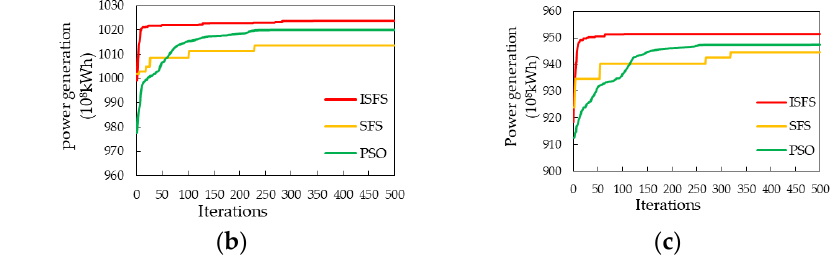
Figure 4. Convergence process of Scheme 3 solved by the three algorithms in ( a ) 2008, ( b ) 2015 and ( c ) 2013.